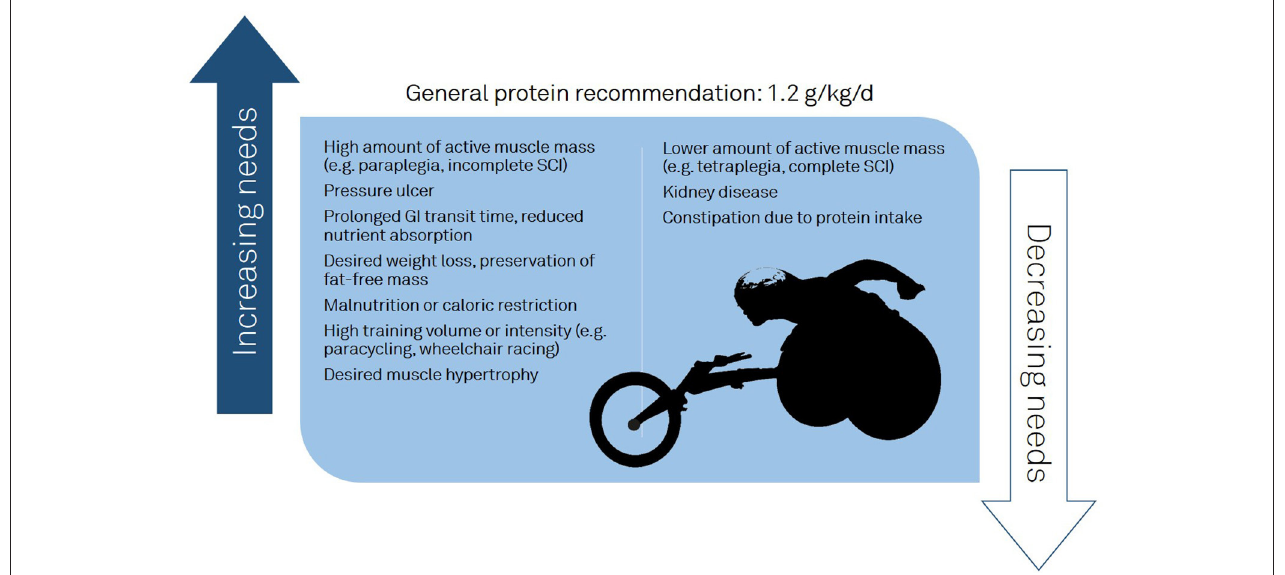
FIGURE 1 | Factors influencing protein recommendations in athletes with a spinal cord